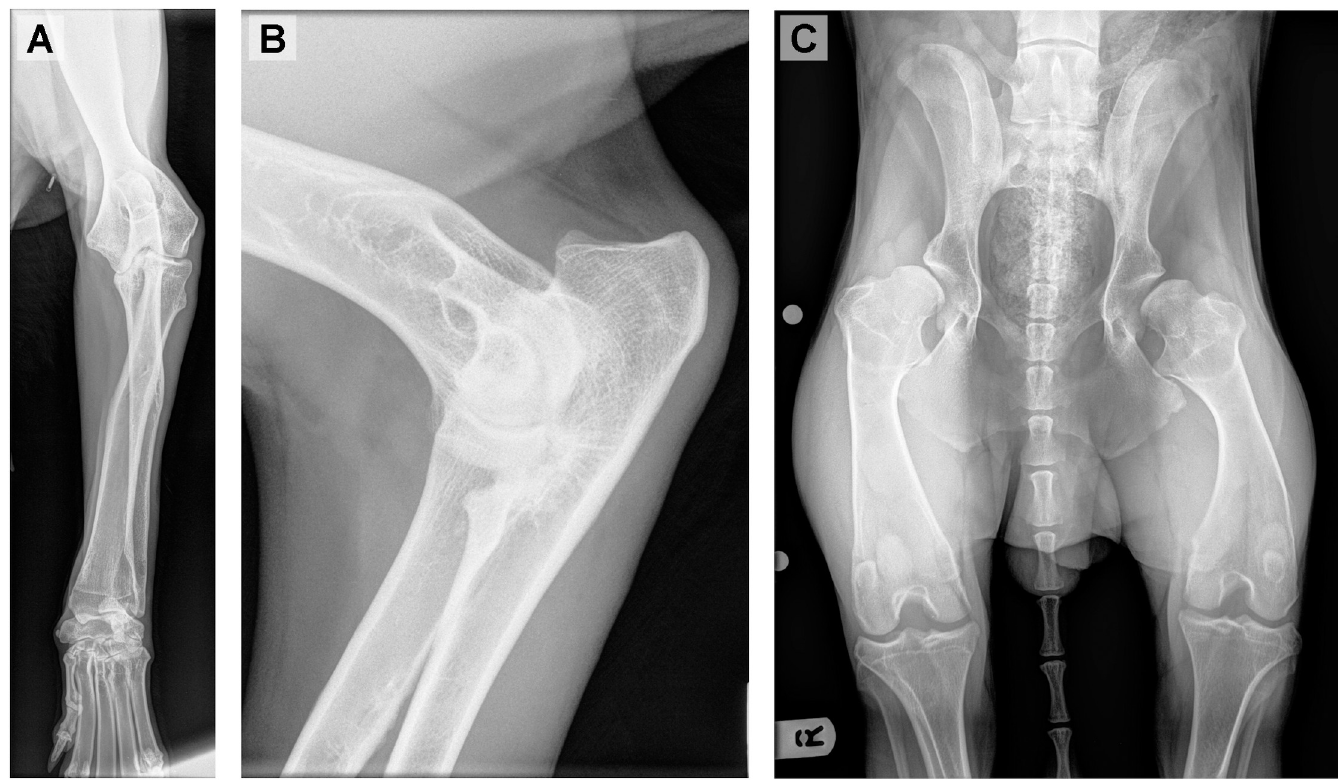
Fig 3. Skeletal defects associated with oculoskeletal dysplasia (OSD) in Northern Inuit Dogs (NID). (A-C) OSD-affected three month old NID (Dog 1). (A-B) Radiography of forelimbs revealed abnormally shortened long bones, antebrachial growth deformity, elbow dysplasia, incongruent elbow joints, radio-carpal subluxation and moderate osteoarthrosis. (C) Skeletal radiography of pelvis and hips revealed severe hip dysplasia consisting of subluxated and remodelled femoral heads and shallow acetabula, and mild osteoarthrosis. Long bones were also abnormally shortened.